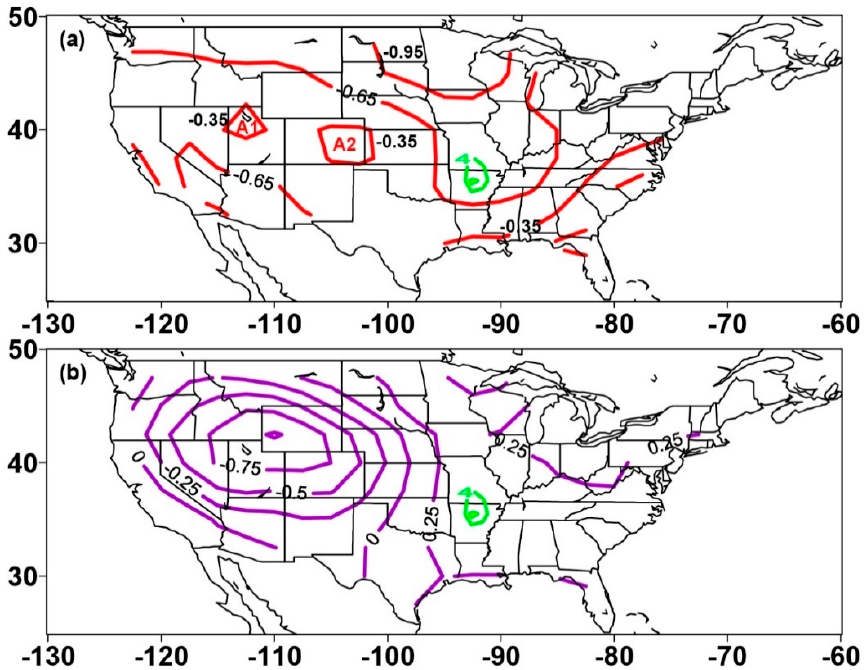
Figure 8. Composite for 10 coldest years of ( a ) surface air temperature anomaly (°C) with relative warm centers labelled A1 and A2, and ( b ) mean sea level pressure anomaly (Pa). The number of 20+ tornado days (contours) over the same period are in green colors in ( a ) and ( b ).